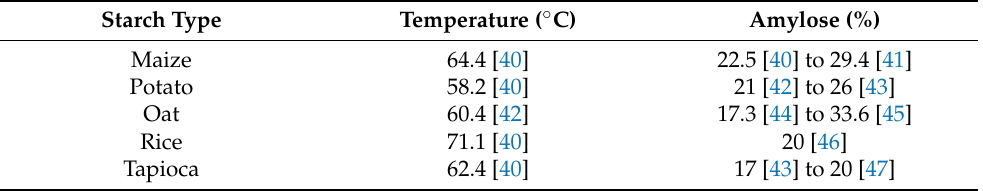
Table 1. Gelatinization temperature and amylose content of various